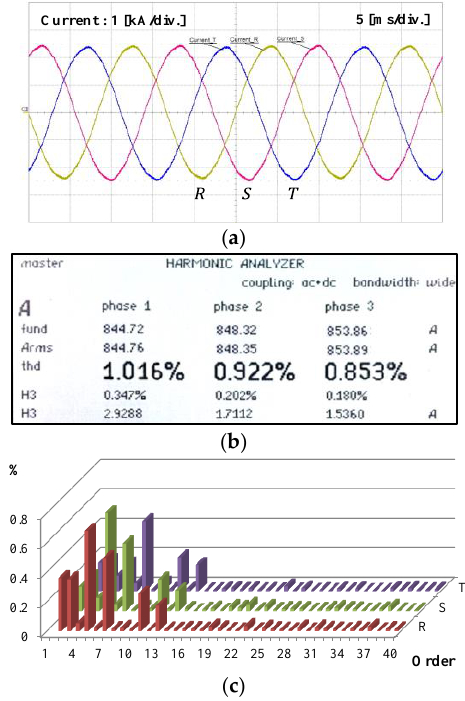
Figure 19. Magnified waveforms of the current and gate signals in the case of a unity power factor at the grid: ( a ) waveforms of the conventional switching method; ( b ) waveforms of the proposed switching scheme.